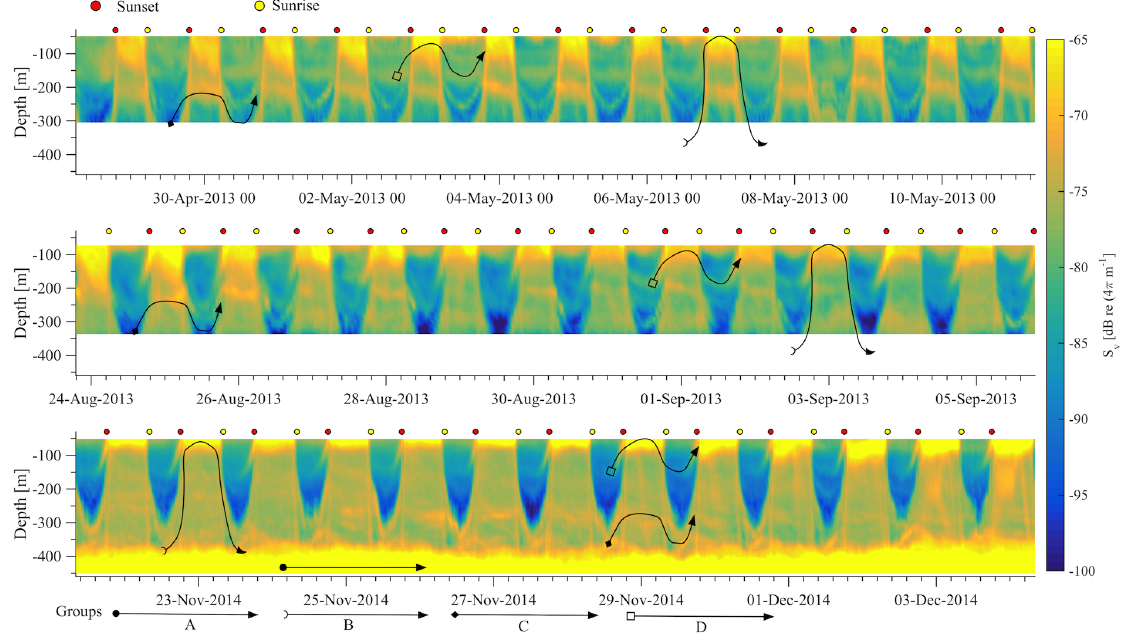
Figure 7. Backscatter coefficient Sv from the 75kHz ADCP placed at the POSEIDON E1-M3A location. Hand-drawn trails are attributed to different groups of zooplanktonic and micronectonic organisms (from Potiris et al., 2018).